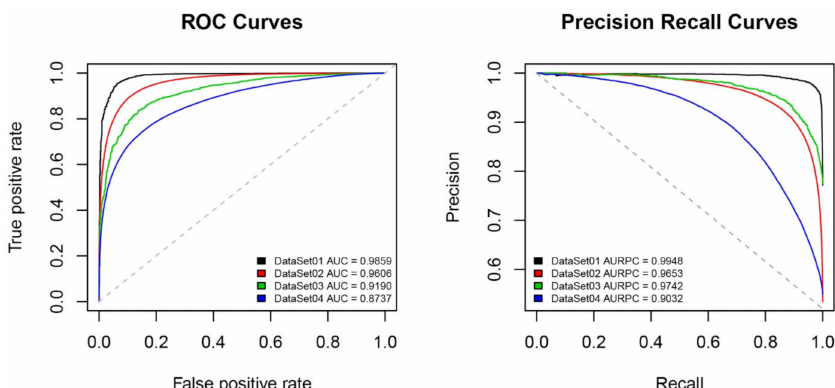
Figure 8. Recall-precision and ROC curves displaying the performance of LightGBM on testing datasets of Dataset 01, DataSet 02, DataSet 03 and DataSet 04. Note that the scale of values on the vertical axis is di ff erent from recall-precision curves (0.5–1.) and ROC curves